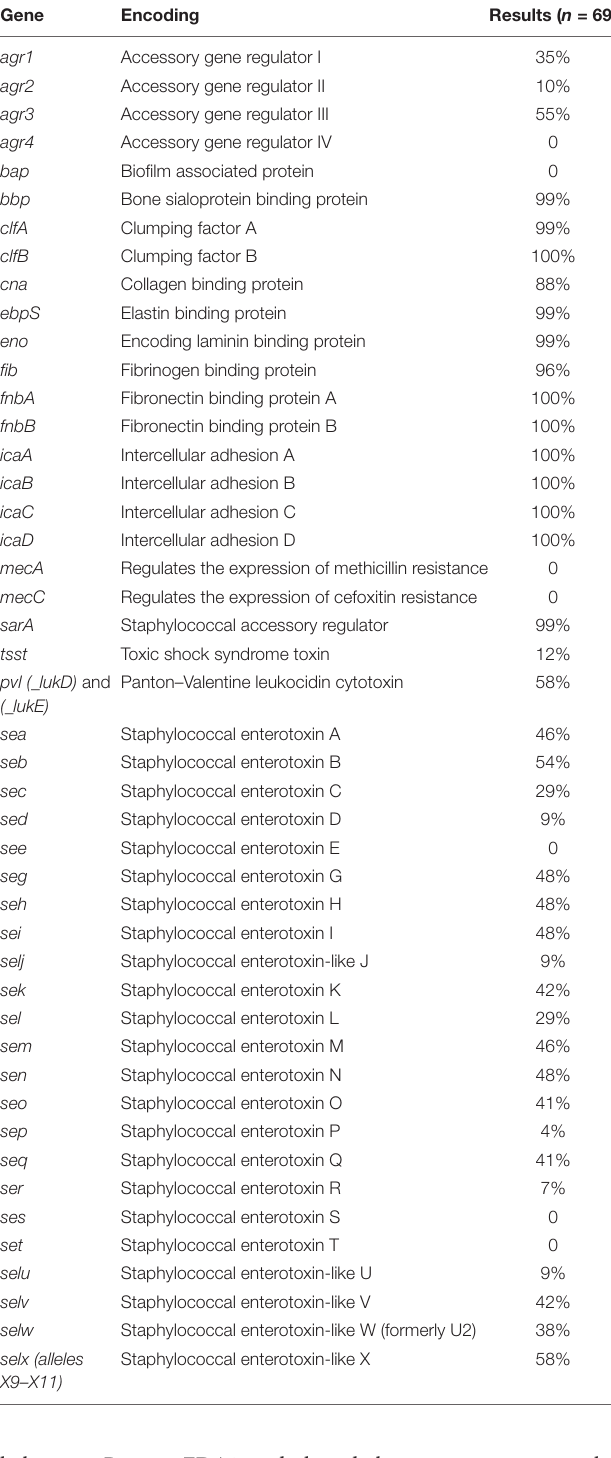
TABLE 1 | Incidence of virulence factors, including enterotoxin genes, for 69 outbreak-linked isolates using WGS analysis. Gene Encoding Results ( n = 69)